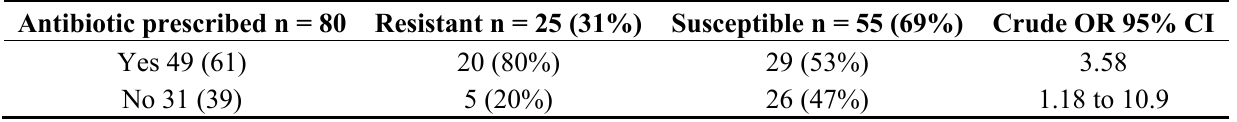
Table 4. Crude association between prescription of any antibiotic in the previous 12 months and trimethoprim resistance in patients admitted to hospital with suspected